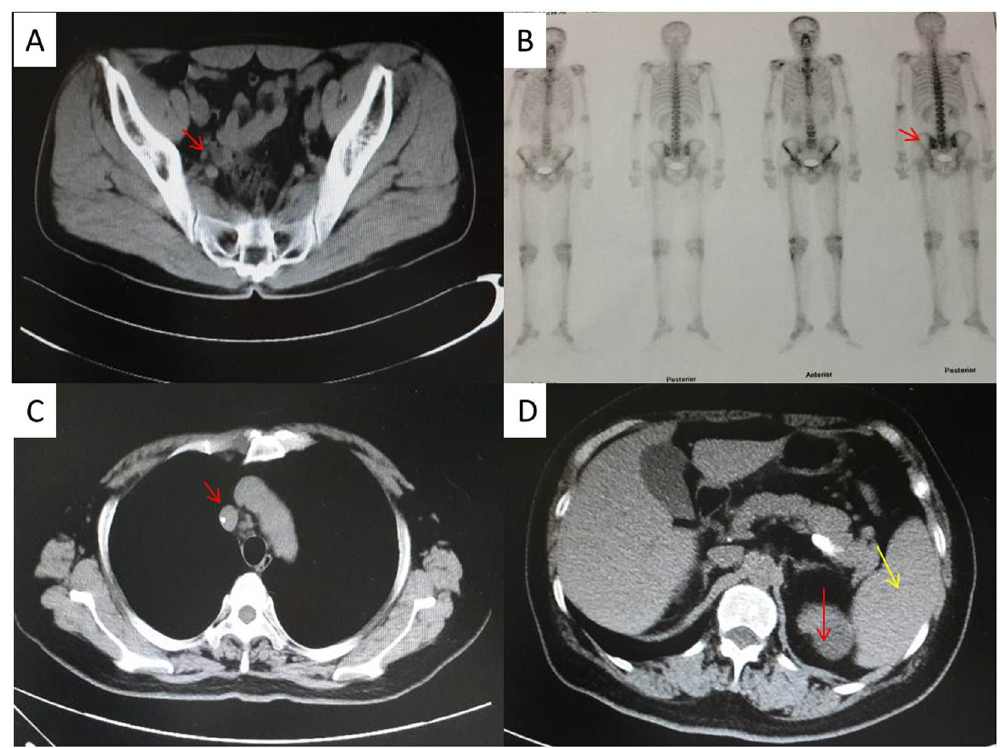
Figure 8. Pelvic CT scanning in case 1 displayed the lymph nodes aside the left external iliac blood vessels enlarged, with the biggest size of 1.8 × 1.4 cm ( A ). PETCT in case 1 showed a high bone salt metabolism in right coracoid and left sacroiliac joint ( B ). Chest CT scanning in case 2 displayed multiple lymph nodes enlarged in right hilar and mediastinal ( C ). Abdomen CT scanning in case 2 displayed a clear borderline mass in the right kidney (red arrow) and a slightly larger spleen (yellow arrow) ( D